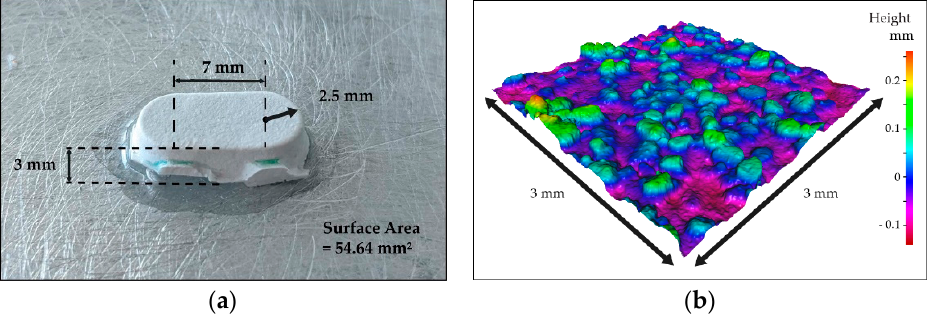
Figure 2. ( a ) A cut out Babolat tread segment with measurements to calculate the nominal contact area; ( b ) Surface scan of hardcourt